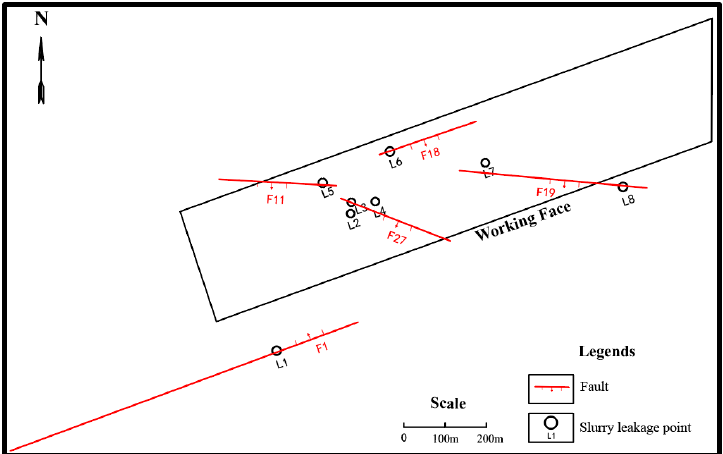
Figure 12. Plan view of the location of slurry leakage points and faults .